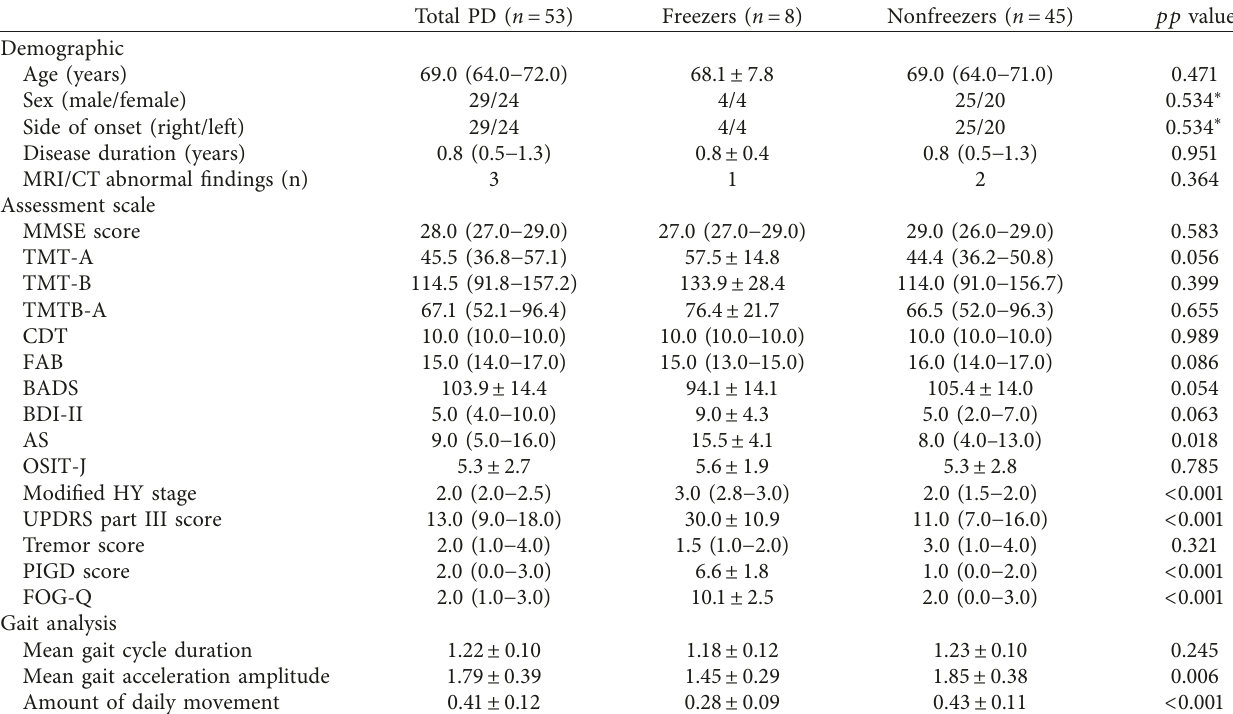
Table 1: Comparison of clinical parameters between FOG and non-FOG